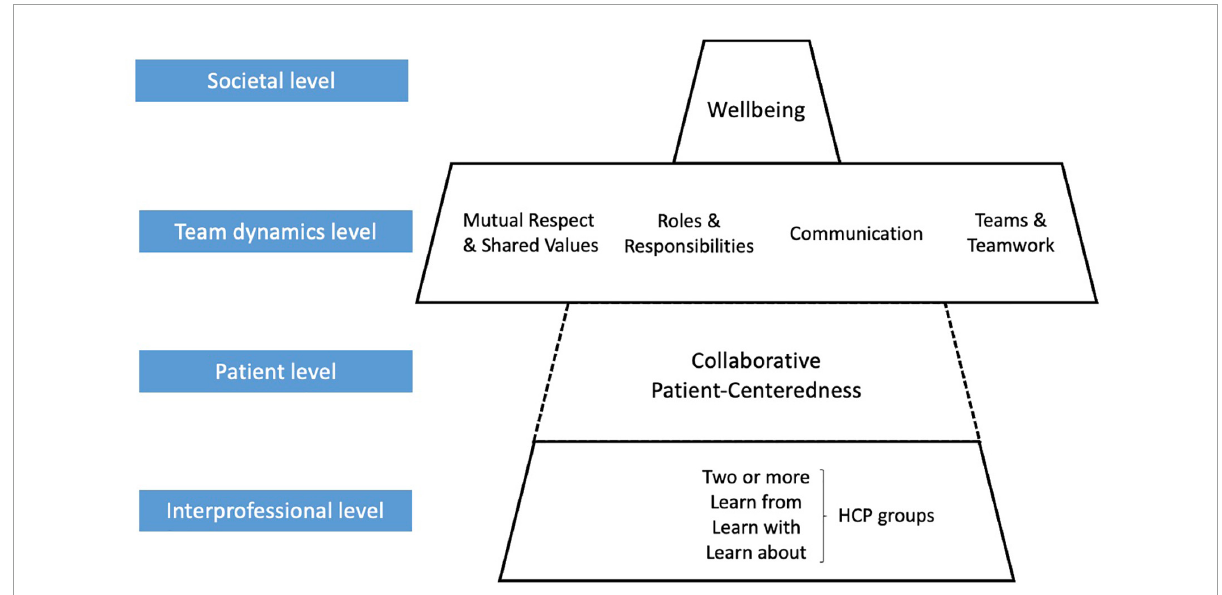
FIGURE3 Final conceptual framework (“the IPE Pagoda”). Updated conceptual framework on IPE, "the IPE Pagoda.” HCP, healthcare